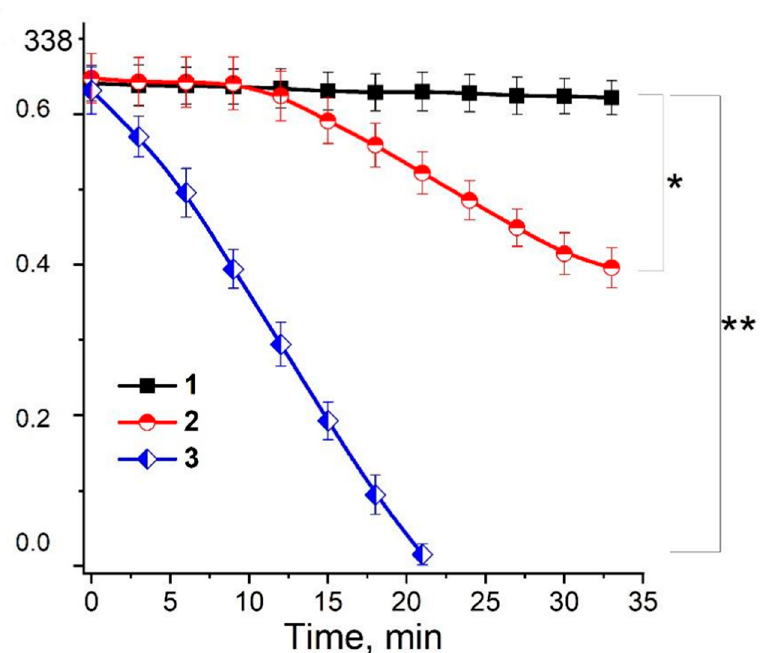
Figure 6. Kinetics of GSNO degradation. Reaction mixture: 0.2 M K,Na-phosphate buffer (pH 8.0) and 0.75 mM GSNO (1); (1) + lysine and MG (both 100 mM) (2); (2) + 0.1 mM CuSO4 (3). Results are depicted as the mean with S.E.M. of three independent experiments ( n = 3). Student t -test (* p ≤ 0.05 for all point after 15 min, ** p ≤ 0.05 for all point after 5 min).